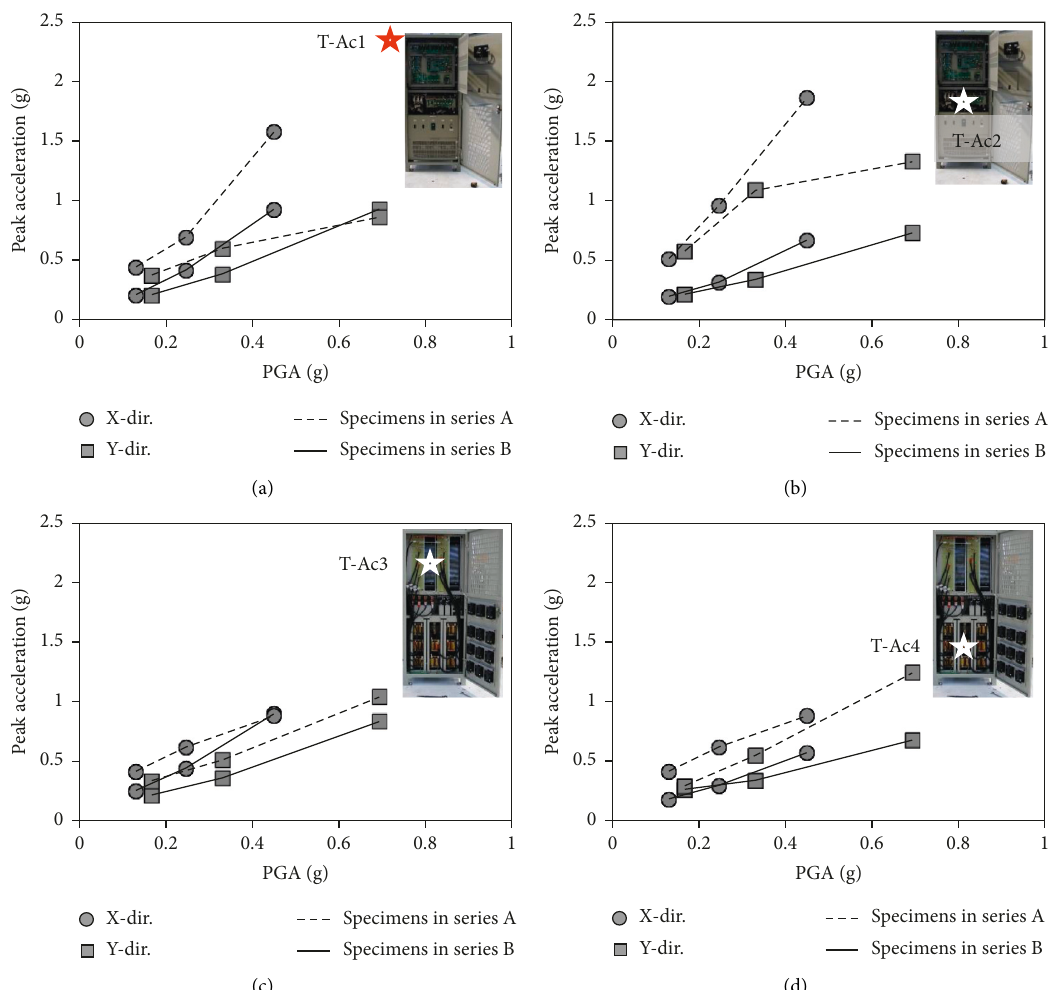
Figure 14: PRA with respect to PGA at different locations of the test specimens in Series A and B. (a) At the top of the UPS. (b) At the control switch. (c) At the cooling system. (d) At the